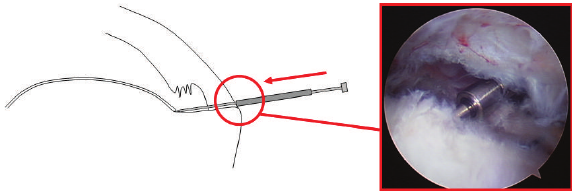
Figure 3: Schematic diagram and corresponding arthroscopic photo (of a right shoulder from a posterior subacromial portal) demonstrating advancement of the outer metallic sleeve to the bursal surface of the rotator cuff. The position of the outer sleeve on the inner metallic rod corresponds to the total tendon thickness.